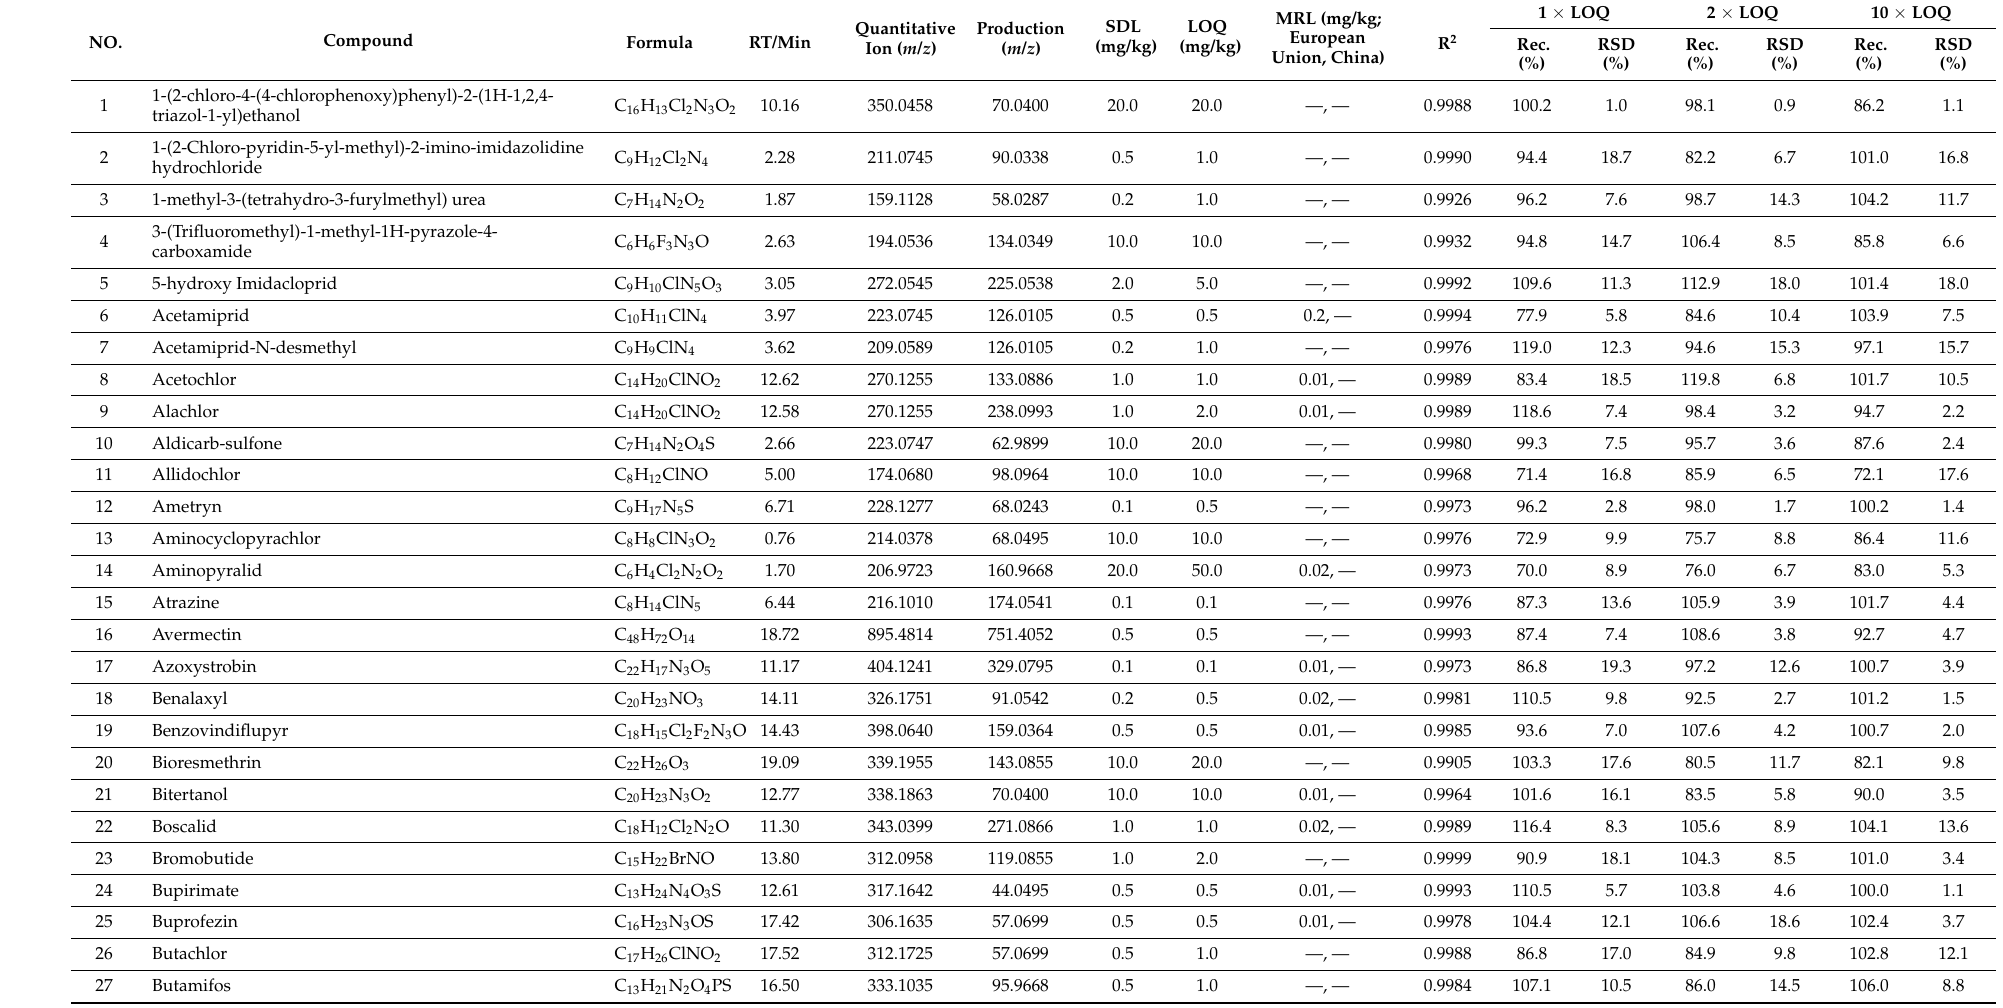
Table 1. LC-Q-TOF/MS parameters and validation parameters for all target analytes in raw